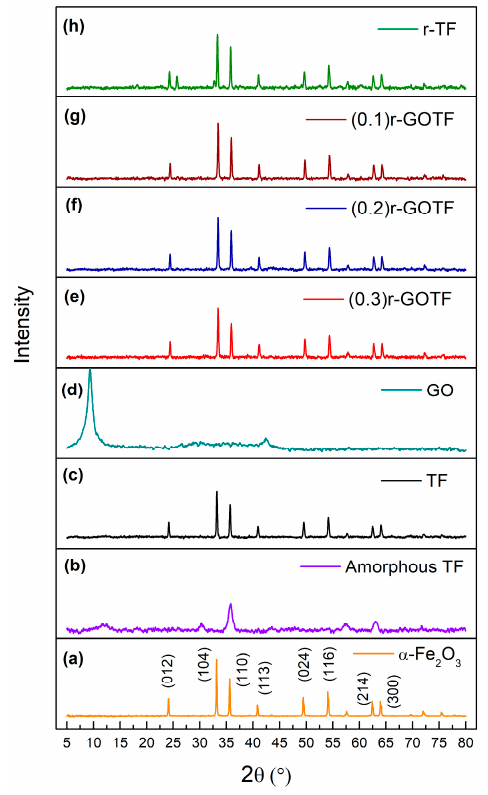
Figure 5. XRD patterns of ( a ) α -Fe 2 O 3 , ( b ) Amorphous TF, ( c ) TF, ( d ) GO, ( e ) (0.3)r-GOTF, ( f ) (0.2)r- GOTF, ( g ) (0.1)r-GOTF and ( h ) r-TF.